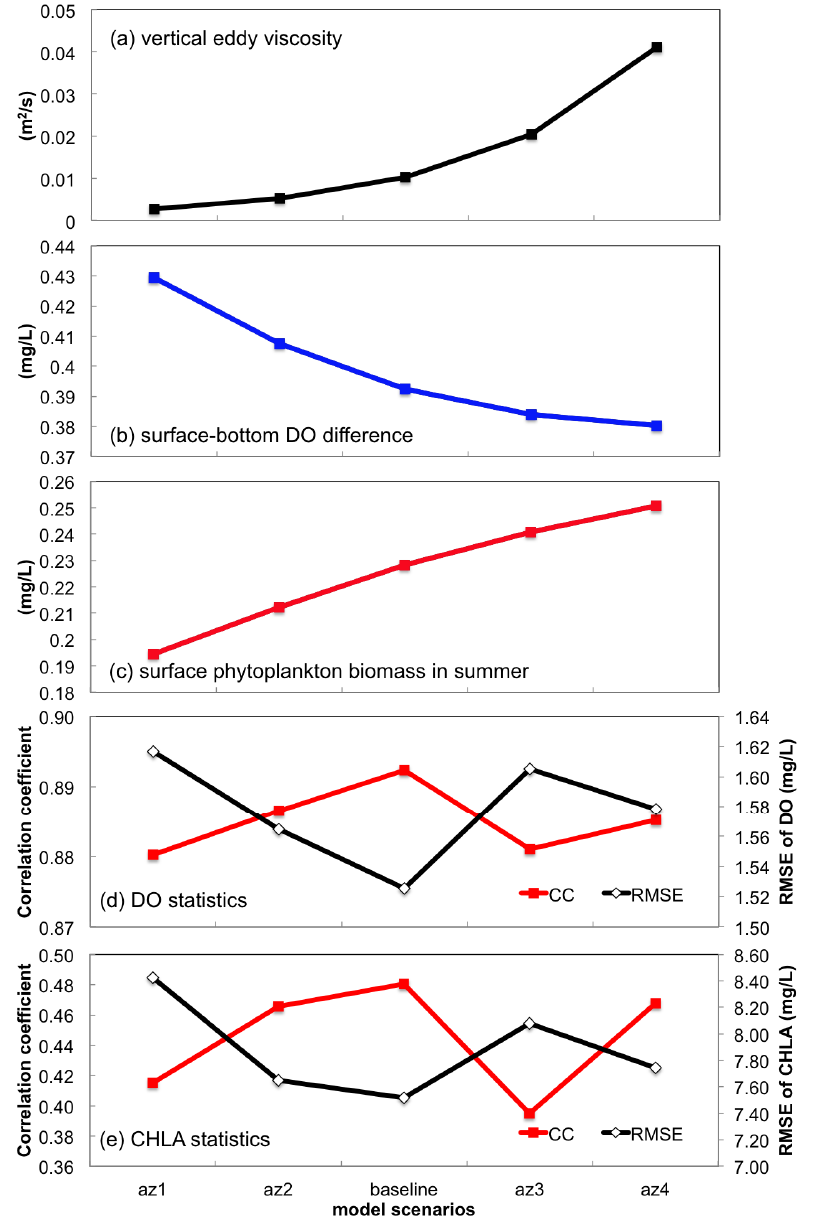
Figure 10. ( a ) The average eddy viscosity; ( b ) the surface-to-bottom difference of dissolved oxygen in the hypoxia season (from May–August); ( c ) surface phytoplankton biomass in summer (from June–August); CC and RMSE of ( d ) dissolved oxygen and ( e ) chlorophyll-a in 2010 in the five scenarios of varying eddy viscosity (az1, az2, baseline, az3 and az4 in Table 2). CC and RMSE denote the correlation coefficient and root mean squared error between the model simulation and the observation, respectively.